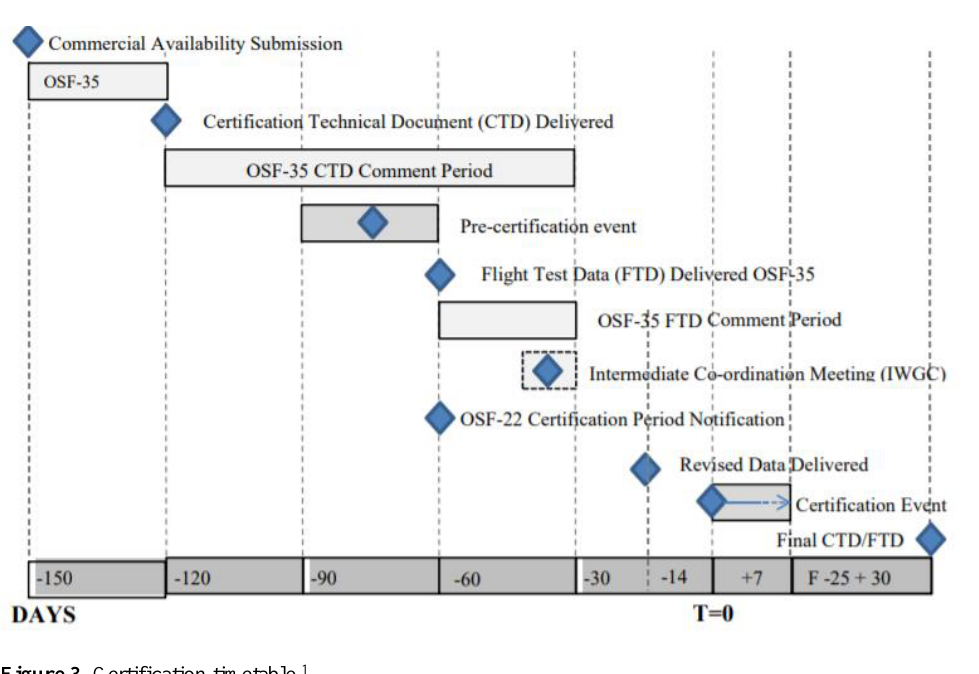
Figure 3. Certification timetable